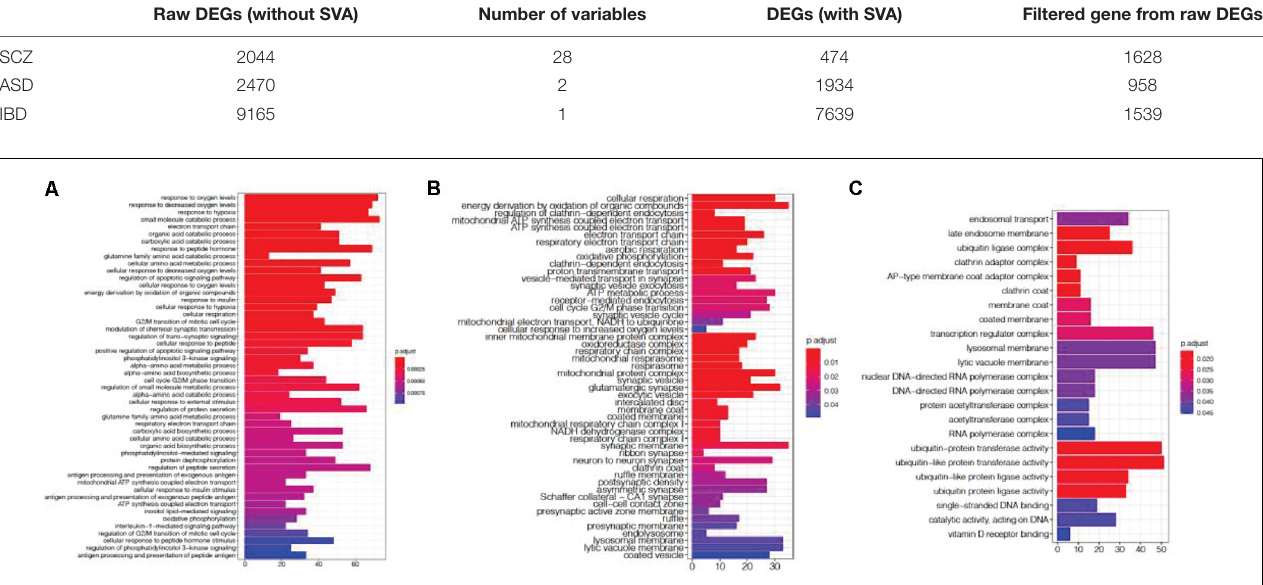
FIGURE 10 | Gene ontology enrichment analysis of SCZ filtered genes (A) , ASD filtered genes (B) , and IBD filtered genes (C) .